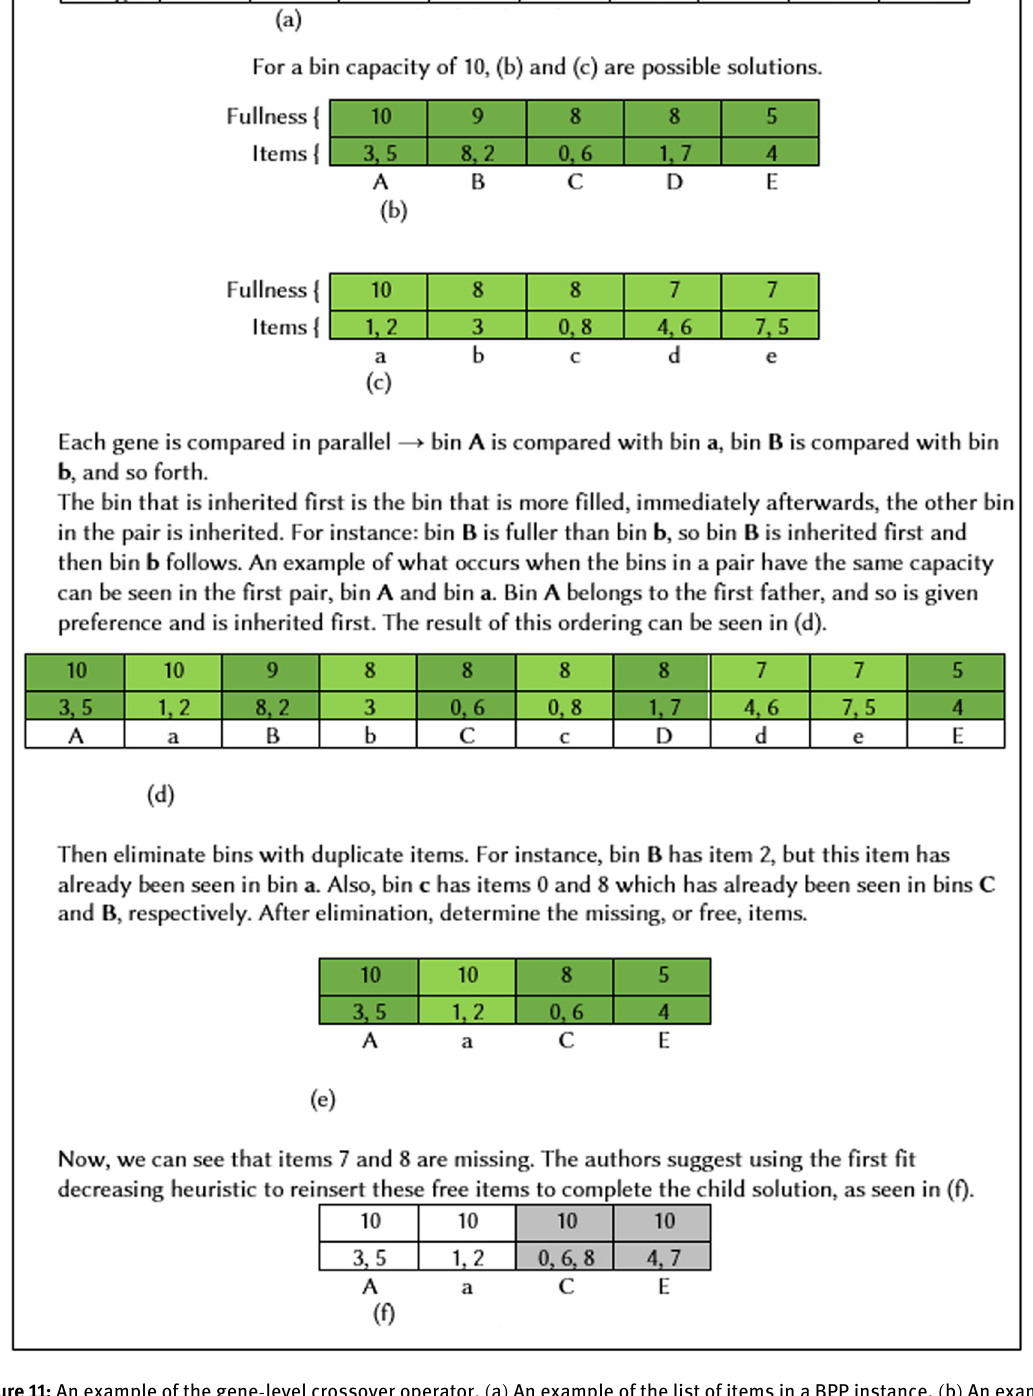
Figure 11: An example of the gene - level crossover operator. ( a ) An example of the list of items in a BPP instance. ( b ) An example of a fi rst father. ( c ) An example of a second father. ( d ) The result of the o ff spring from the fi rst and second father in the examples. ( e ) Partial solution after removing duplicates. ( f ) The completed child solution. Source: [ 35 ]